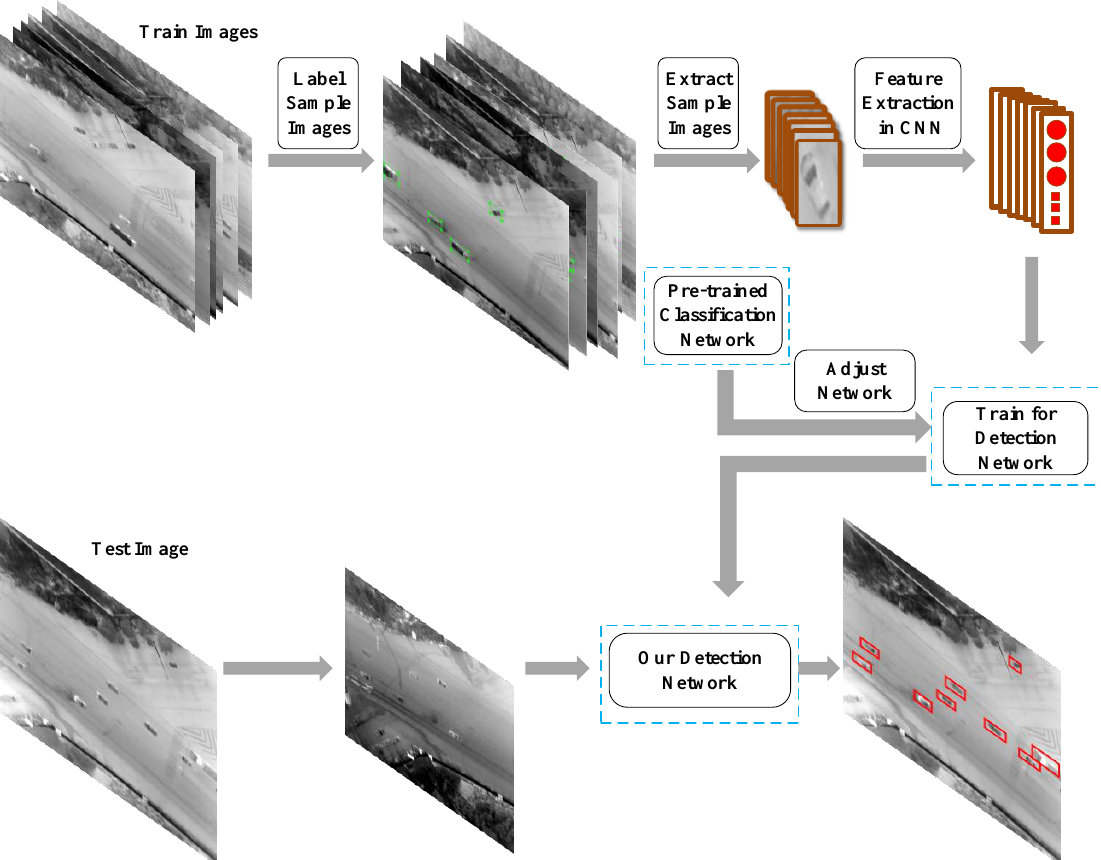
Figure 2. Flowchart of the proposed vehicle detection method in infrared images. Before training, we manually label vehicles in images via labelimg tool. In the label, we rectangle the vehicle by locating the top left corner and down right corner, and then keep these location and label information as a xml file. Afterwards, it is necessary to expand the sample by the operations—rotation, crop and